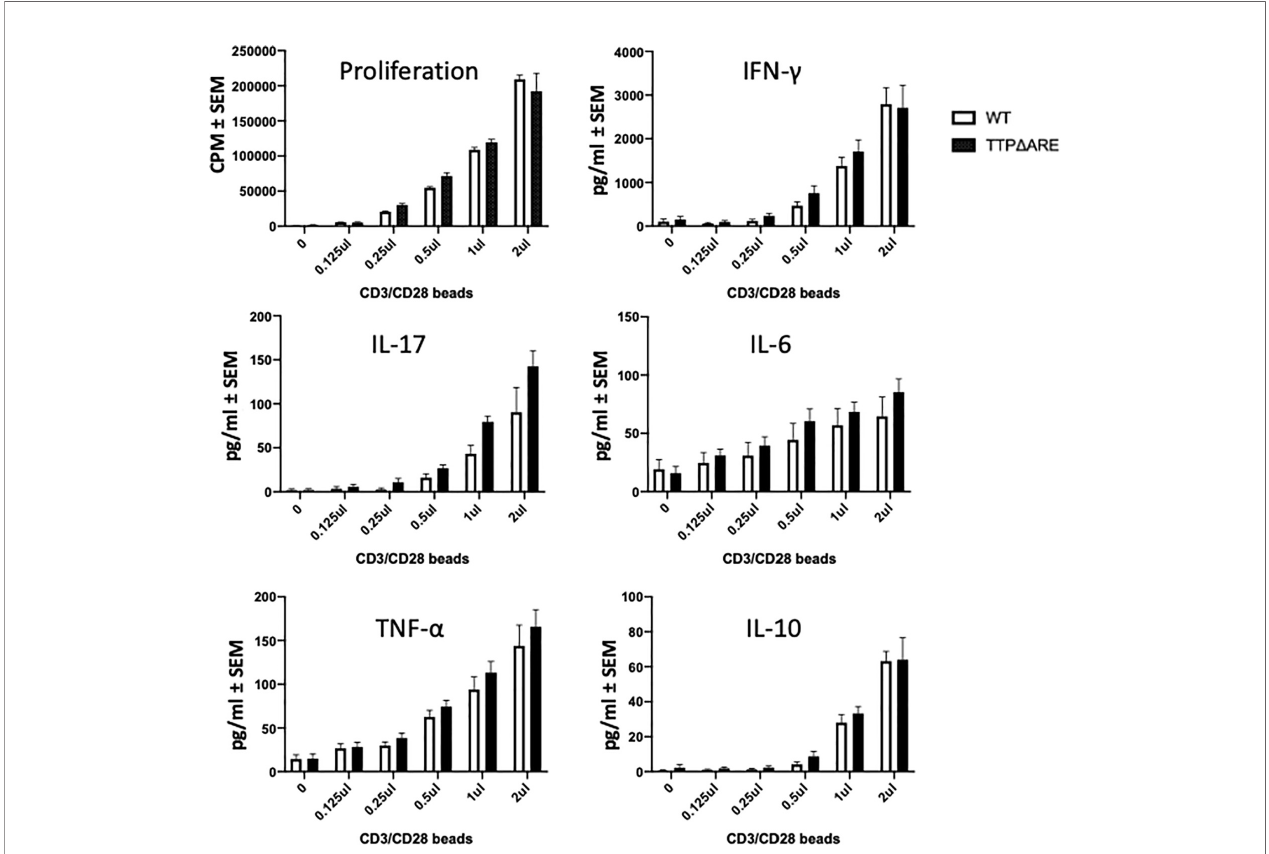
FIGURE 7 | T-cells from TTP D ARE mice resemble their WT controls in their response to stimulation by beads coated with anti CD3/CD28 antibodies. CD3 column-enriched T cells were stimulated with increasing volumes of the beads for 48 h. Lymphocyte stimulation was determined by proliferation assay and by release of cytokines. t-test was used for statistical comparisons. Combined data of three experiments.